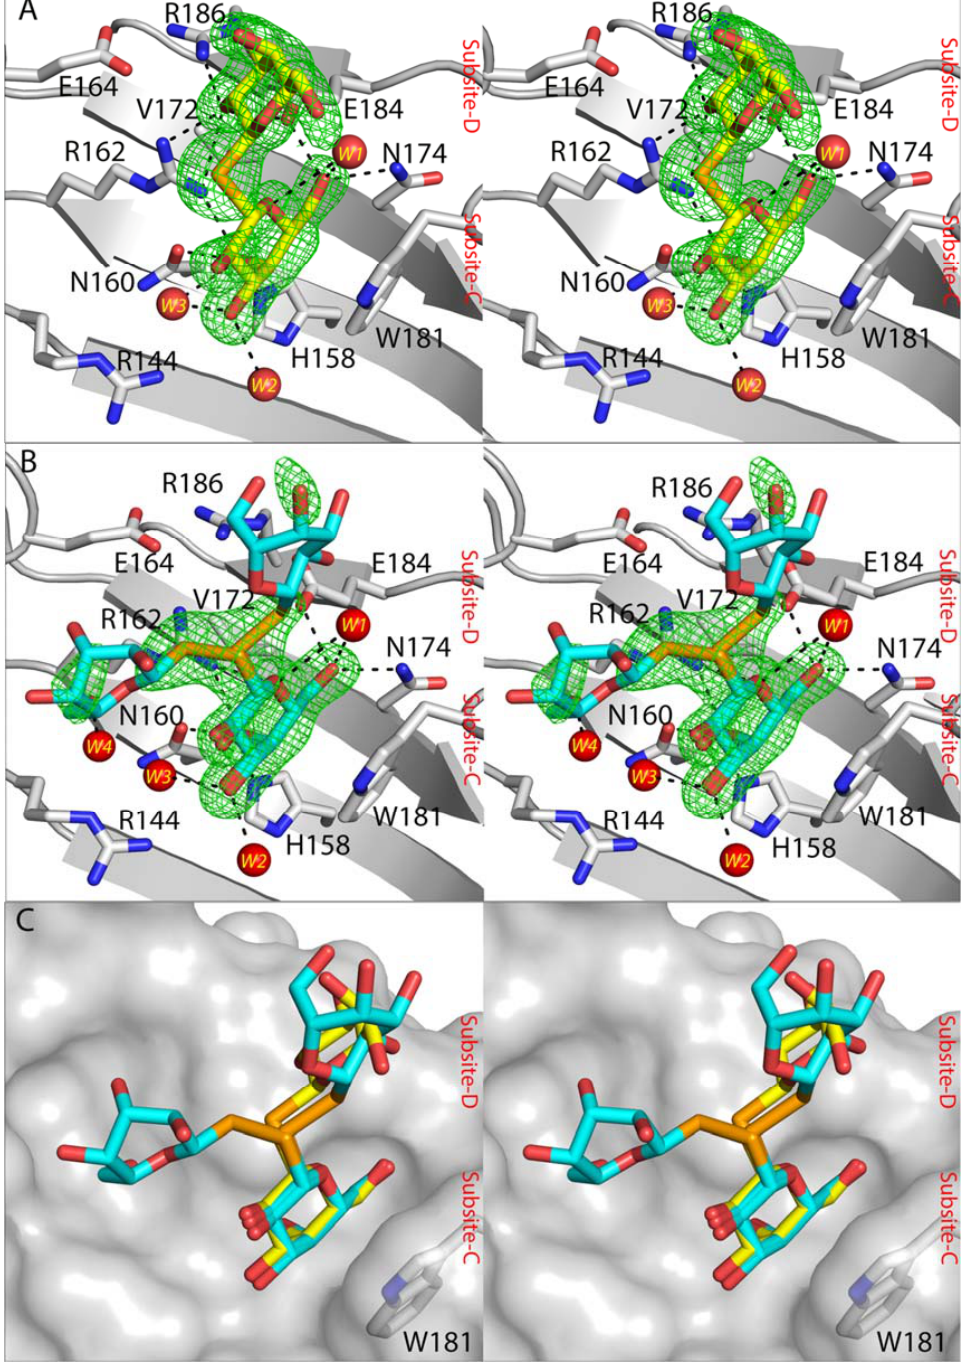
Figure 3. ( A ) 2 │ F o │ − │ F c │ α c map for SeDG (yellow colour sticks) (PDB ID 7RDP) in complex with h Gal ‐ 3 CRD at 1 σ . ( B ) DSeDG (cyan colour sticks) (PDB ID 7RDO) at 1 σ in complex with h Gal ‐ 3.